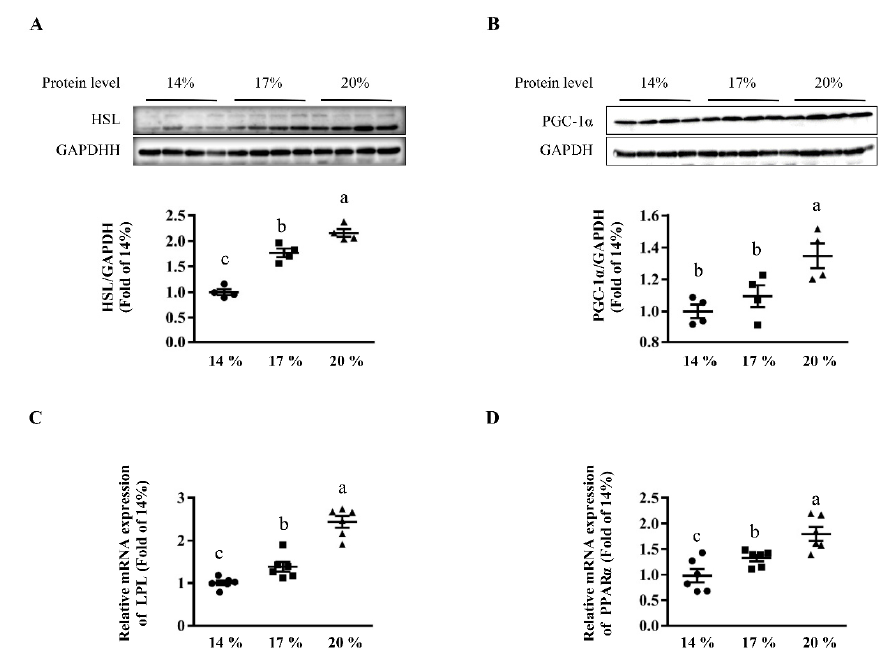
Figure A3. Effects of dietary crude protein level on hepatic lipolysis, and lipid oxidation. Immunoblot analysis of HSL ( A ) and PGC-1 α ( B ) protein abundances, LPL ( C ), and PPAR α ( D ) mRNA abundance in the liver of weaned piglets fed different dietary crude protein. Values are means ± SEMs, n = 4 (protein abundance) or 6 (mRNA expression). Means without a common letter differ, p < 0.05. HSL, hormone-sensitive lipase; PGC-1 α , peroxisome proliferator-activated receptor gamma coactivator 1-alpha; LPL, lipoprotein lipase; PPAR α , peroxisome prolifera-tor-activated receptor alpha.